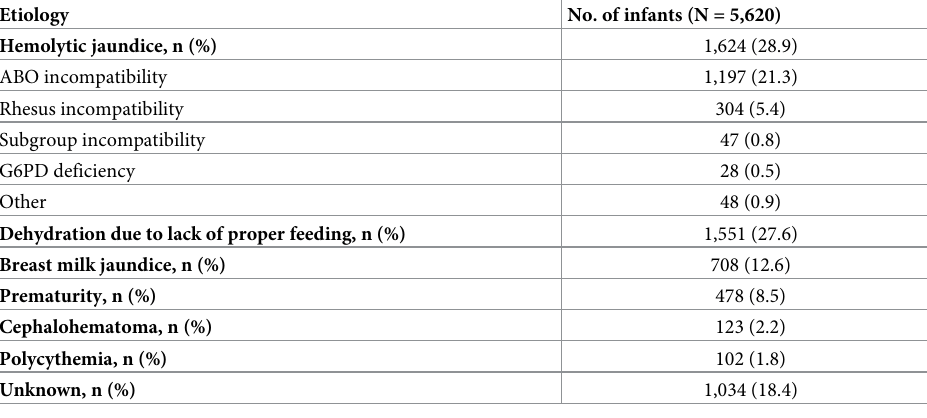
Table 2. Underlying conditions of infants with